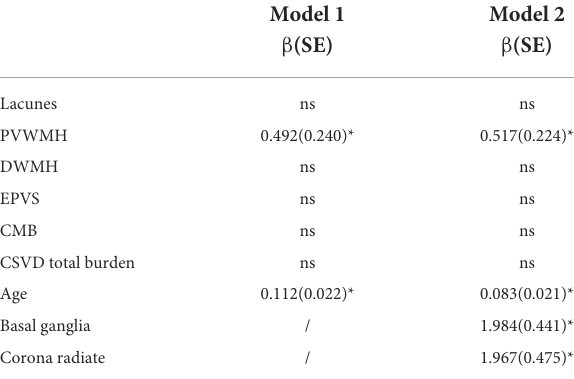
TABLE 5 Independent predictive analysis of timed-up-and-go test by CSVD in patients with minor